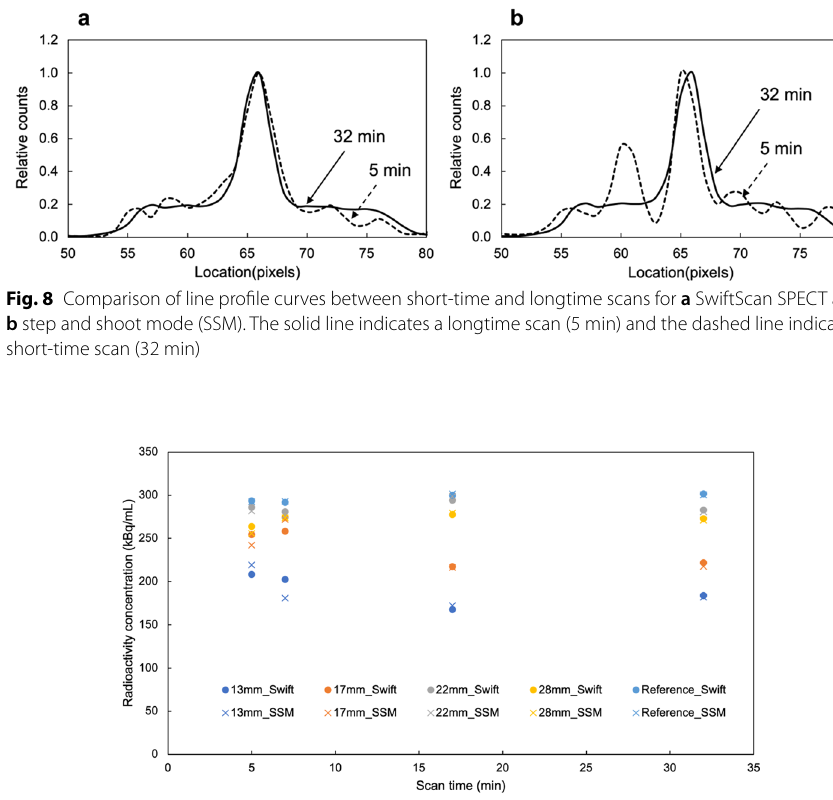
Fig. 9 Radioactivity concentration for each diameter of tumor bone area at various scan times. Circles indicate SwiftScan SPECT and cross marks indicate step and shoot mode (SSM)